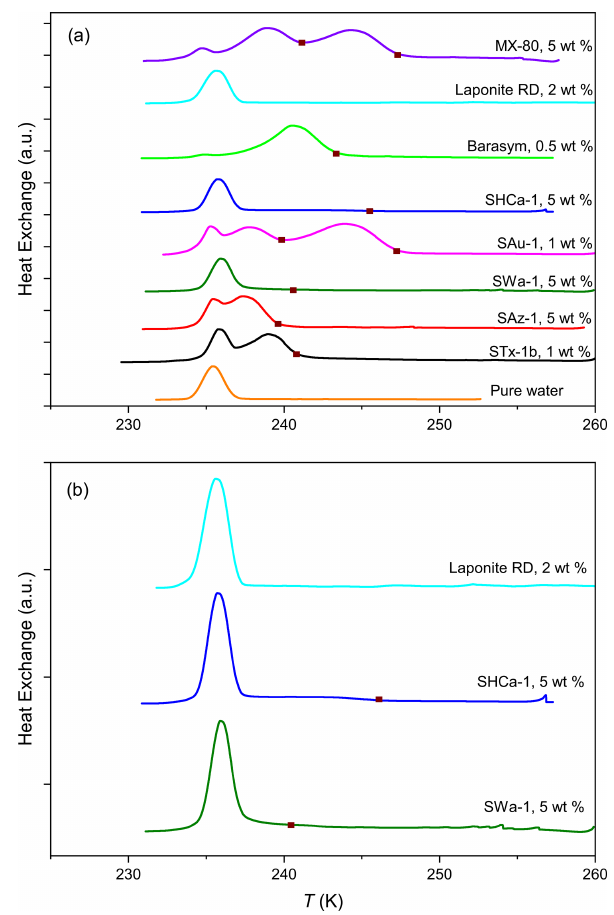
Figure 1. (a) DSC thermograms of all investigated smectites from emulsion freezing experiments at concentrations as indicated on the curves. For clarity, the highest freezing signals in all curves are nor- malized to the same height. For reference purposes, a DSC ther- mogram for pure water (orange curve) is added, showing only the homogeneous freezing signal. The brown squares depict the hetero- geneous freezing onsets ( T het ) for the samples. (b) DSC thermo- grams of three samples (Laponite RD, SHCa-1, and SWa-1) with either weak or no distinct heterogeneous freezing signals shown separately for